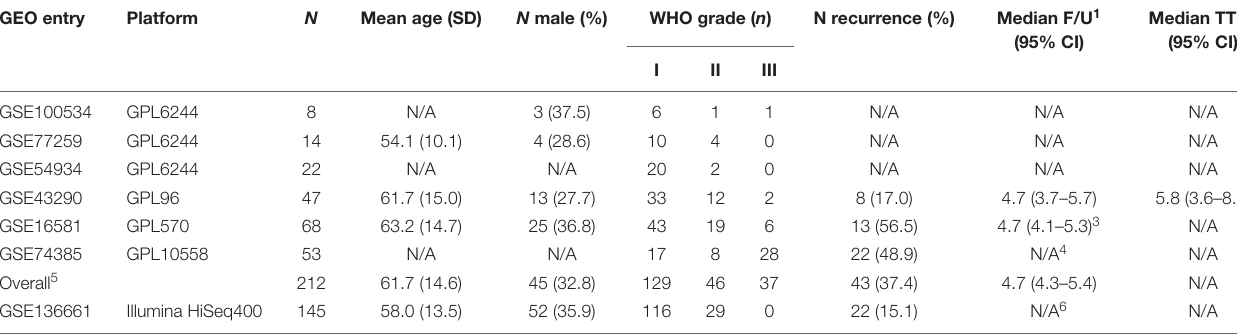
TABLE 1 | Study demographics. GEO entry Platform N Mean age